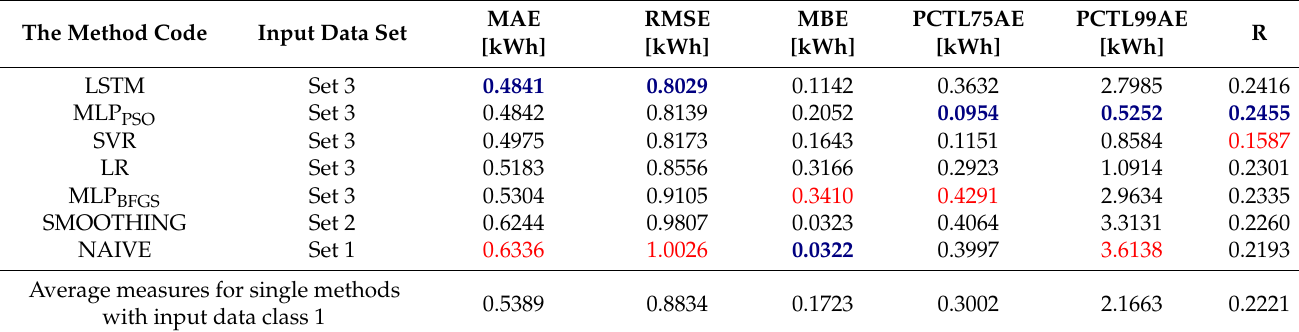
Table 7. Performance measures for single methods with input data class